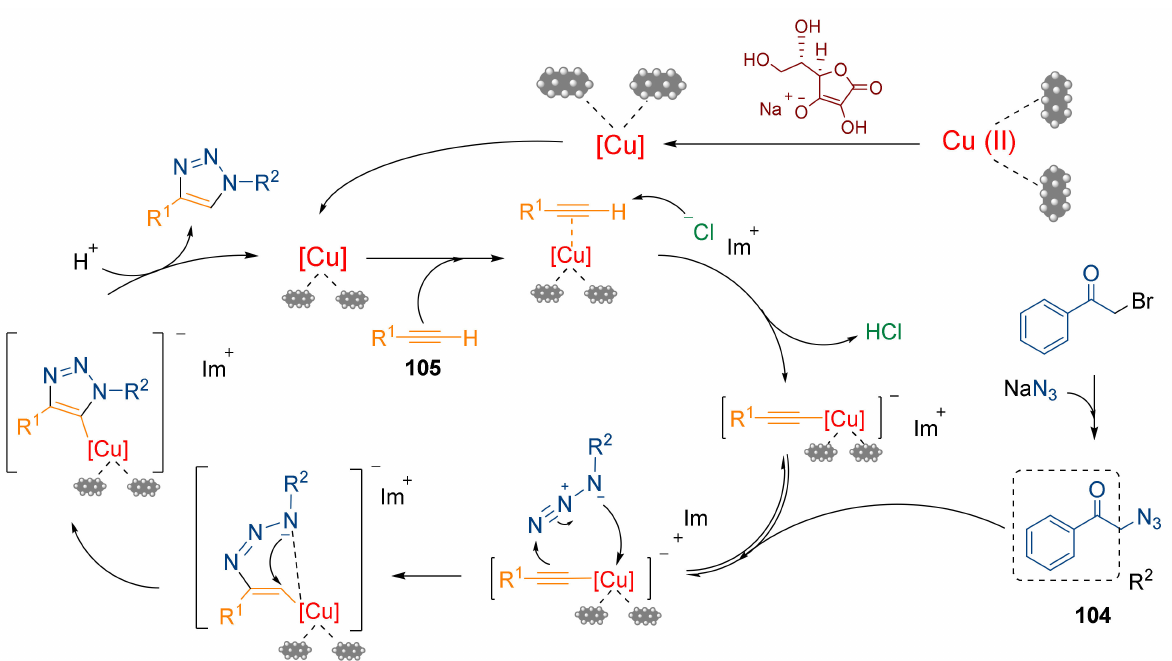
Figure 7. Fe 3 O 4 @CNF-ImSalophCu-catalyzed mechanism for 1,4-disubstituted 1,2,3-triazoles synthesis.